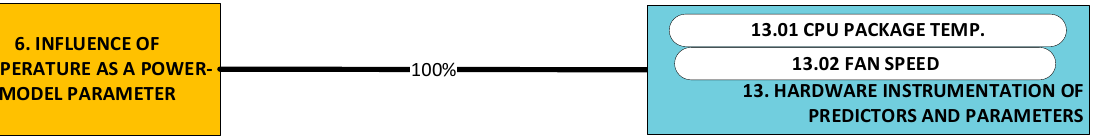
Figure 8. Approaches to solving challenges in category P6; utility metric U A ness and as a percentage. RUs in the respective categories are the following: P6: [60,81,82]; A13: [60,81,82].